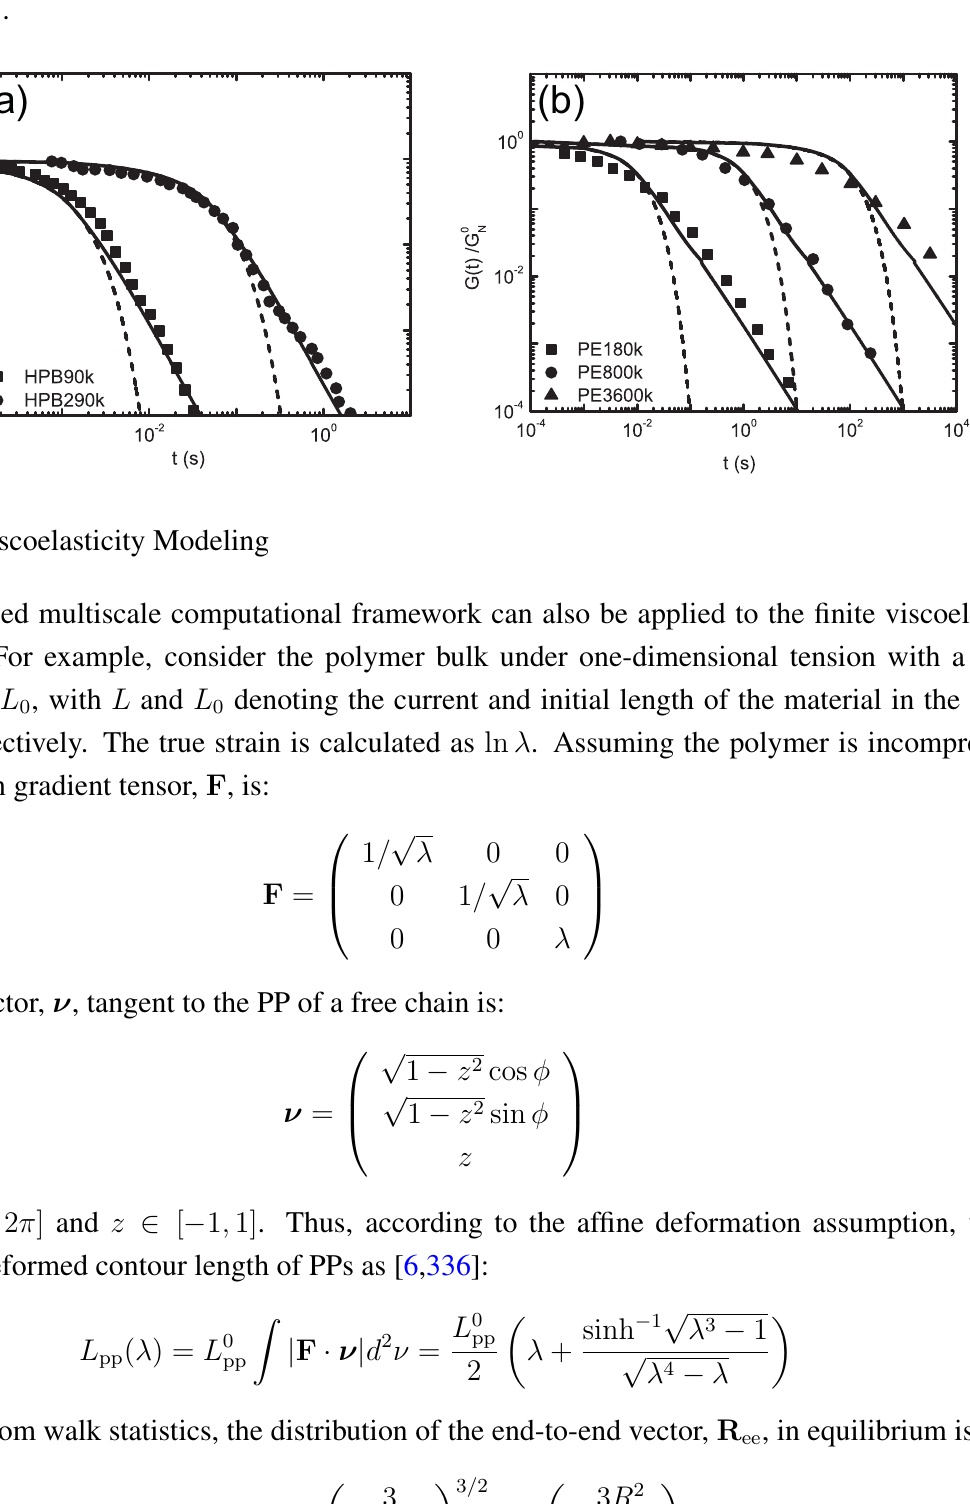
Figure 26. Normalized viscoelastic relaxation of various PE polymers at 463 K: ( a ) HPB TM and ( b ) PE. In ( a ), the dots are experimental results [334]. The solid and dash lines are given by the hierarchical method with α = 0 . 7 and 1.0 when t > τ , respectively. In ( b ), d the dots are experimental results [335]. The solid and dashed lines are from the hierarchical method with α = 0 . 3 and 1.0 when t > τ , respectively. Figure reproduced with permission d from